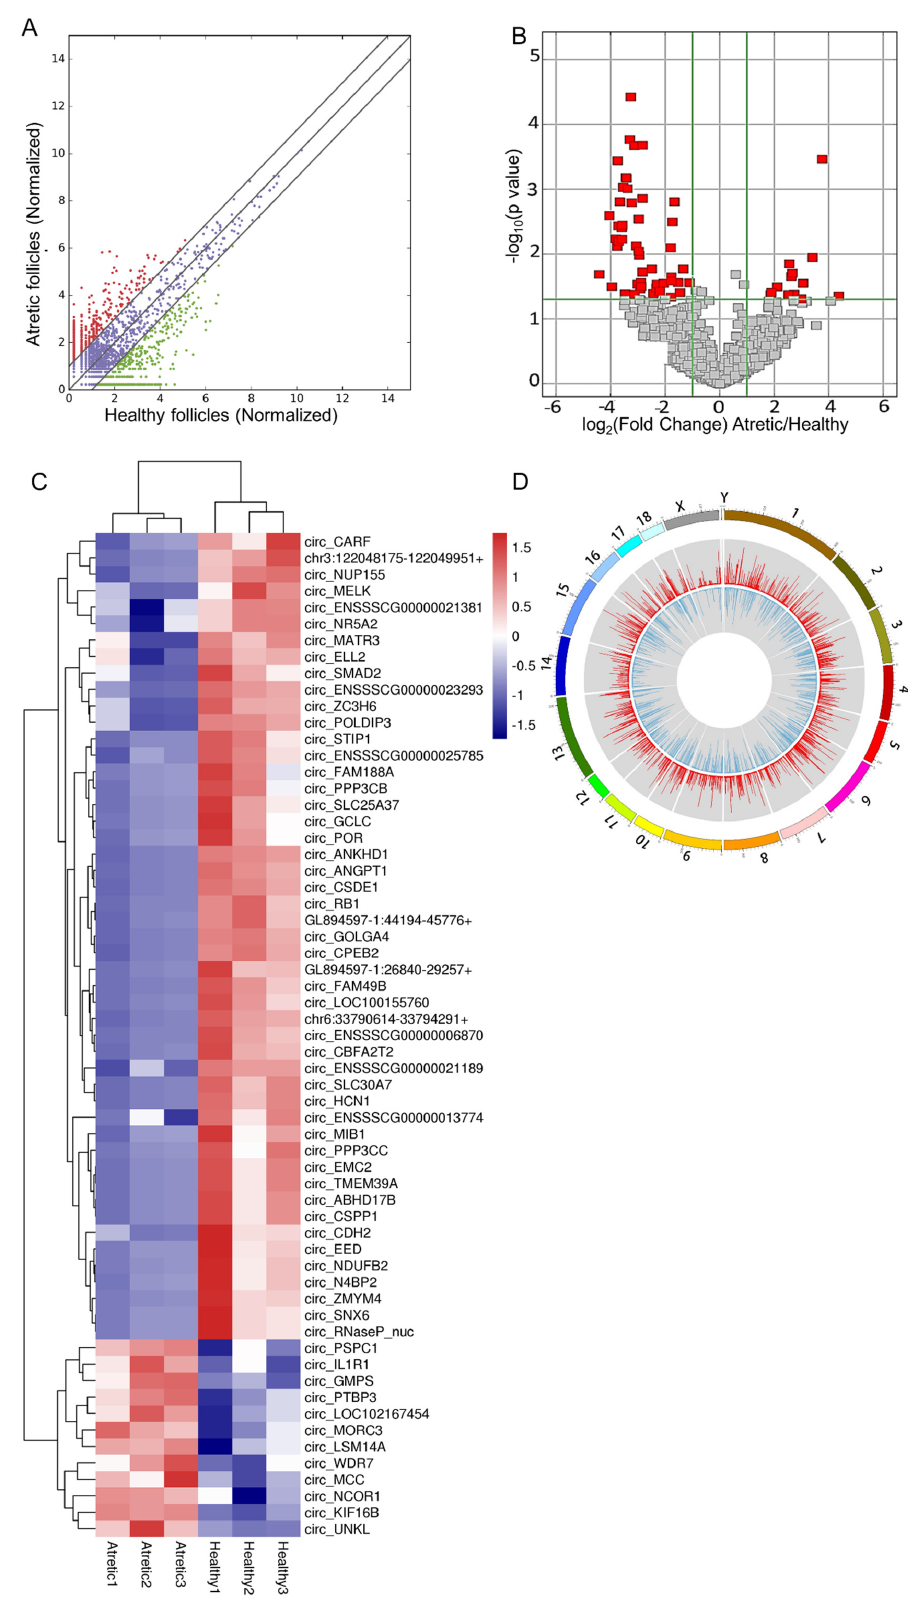
Figure 3. Profiles of di ff erentially expressed circRNAs (DE-circRNAs). ( A ) Scatter plot, assessing the overall distribution of DE-circRNAs between HA and AA follicles. Values on the horizontal and